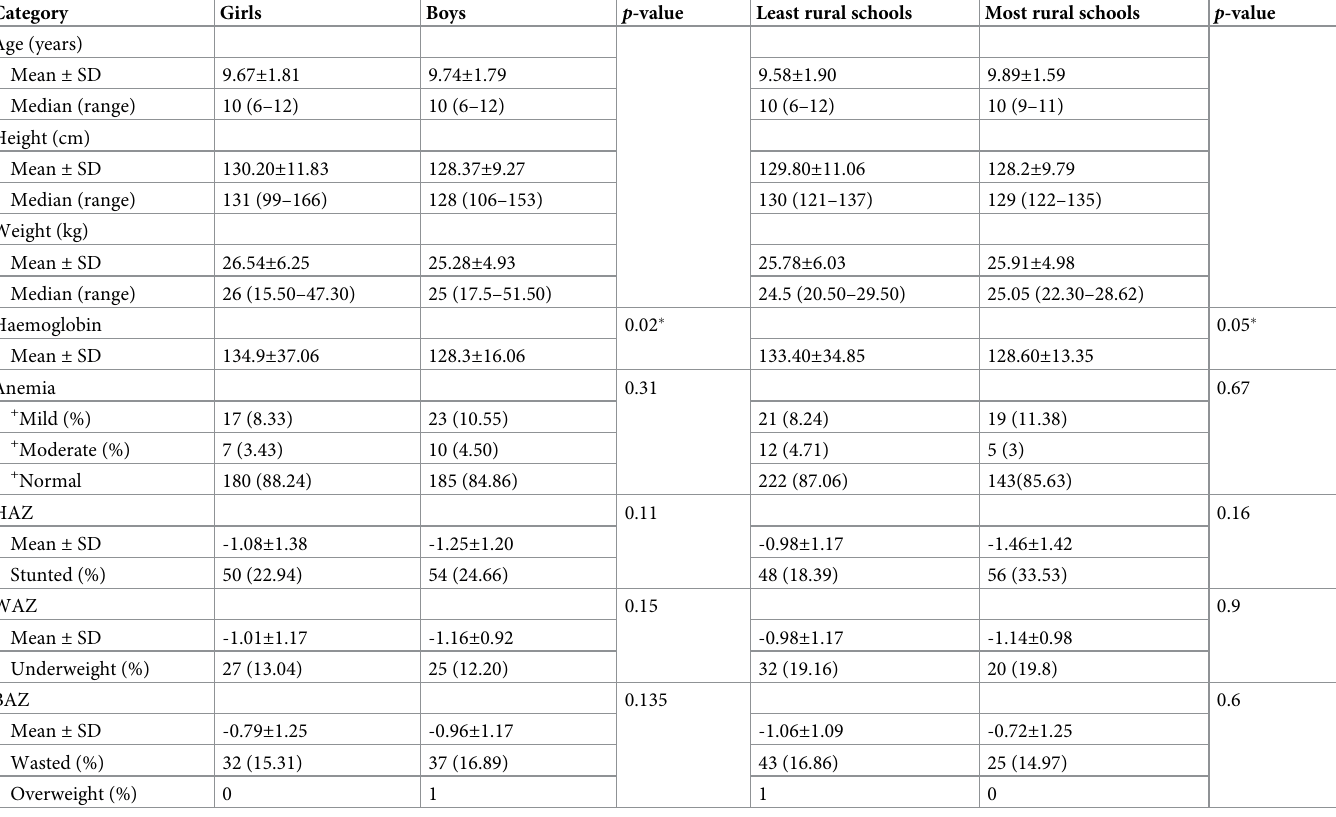
Table 1. Frequency of nutritional indicators and anemia among schoolchildren in Kikwawila and Kiberege wards, Tanzania, stratified by sex and location of the school.